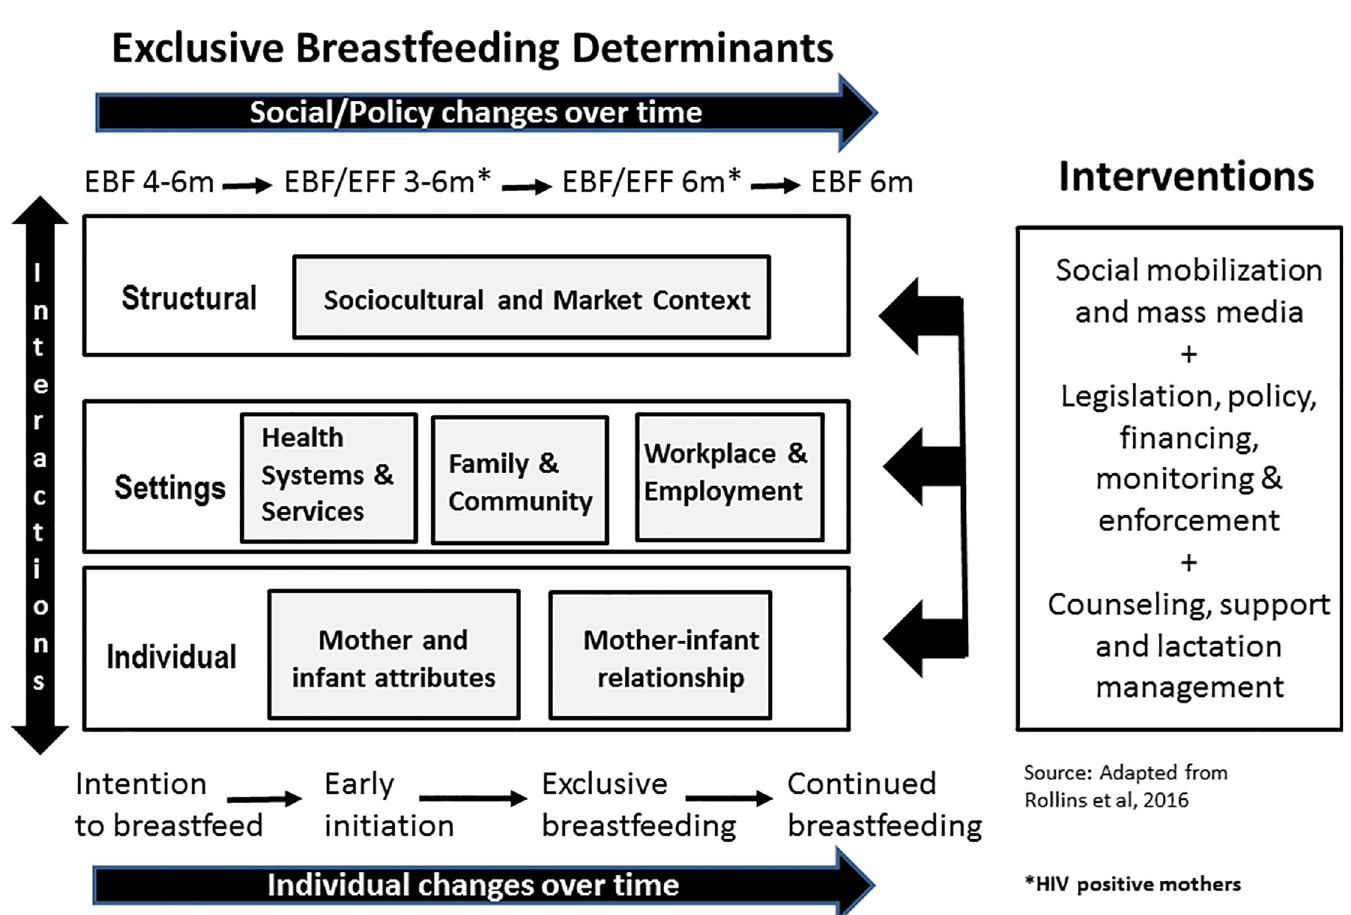
Fig 1. Adapted ecological model for breastfeeding determinants and